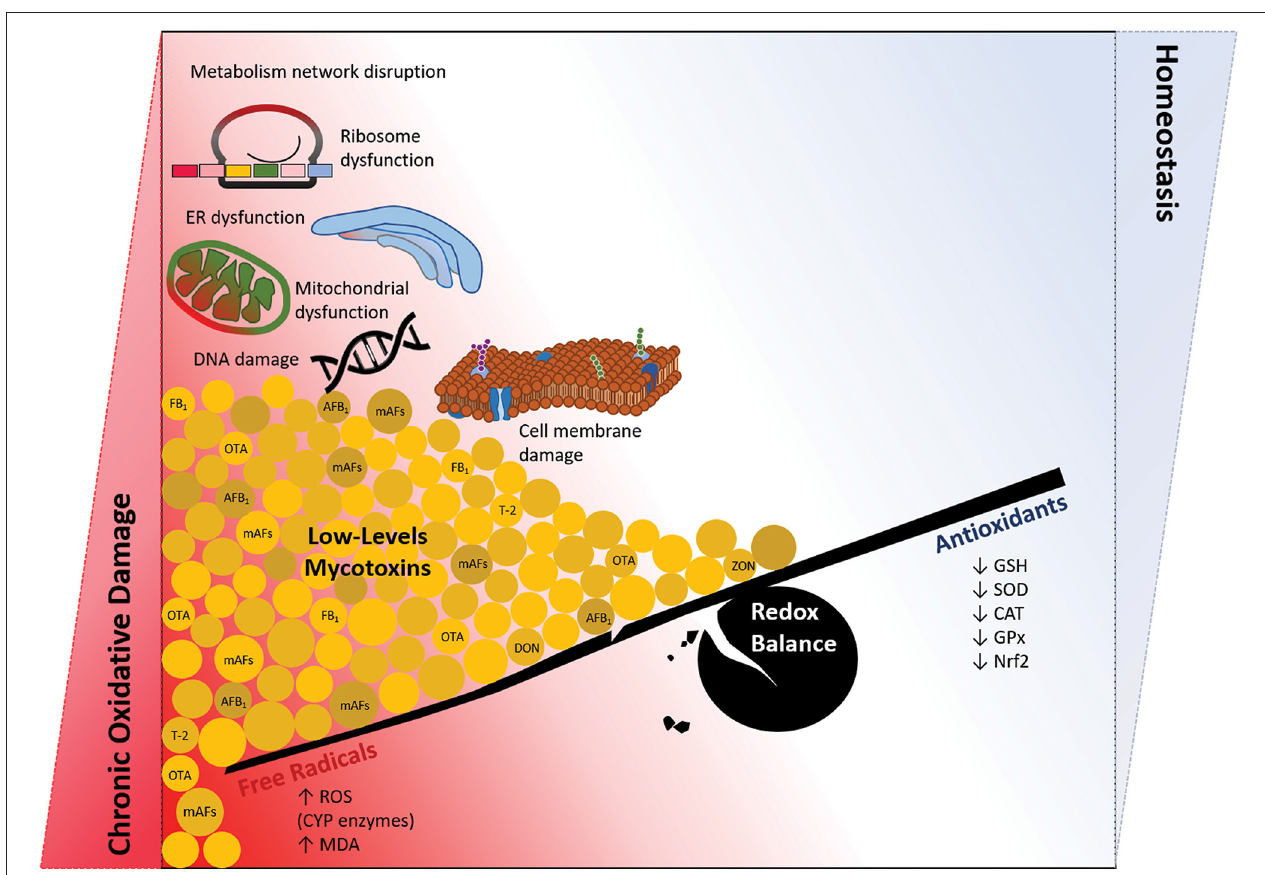
FIGURE 1 | Long-term exposure to foods and feed contaminated by low doses of mycotoxins; the chronic oxidative damage vs. hemostasis. Coexposure to the mixture of mycotoxins, especially at nanomolar doses below the allowable levels ( 40), induces a chronic condition of oxidative disturbance in the cells. There would not be the context of redox balance regarding a continuous production of free radicals and loss of antioxidants defense system. Then, significant damage to macromolecules (DNA, protein, and lipid), organelles (mitochondria, ER, and ribosome), and metabolism network in the cell may orchestrate several pathophysiological conditions, including cardiovascular